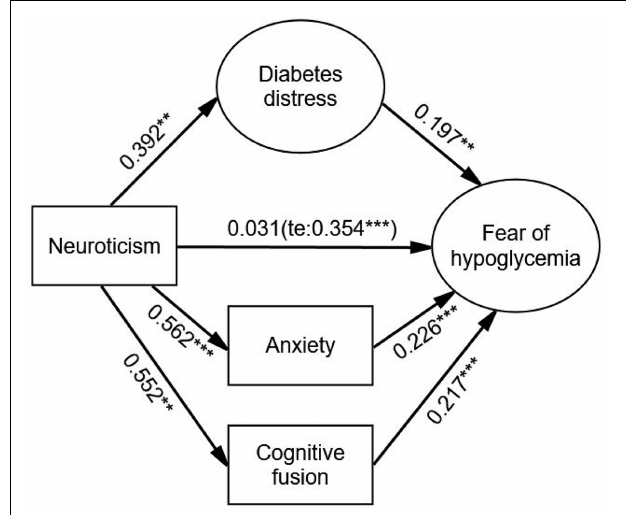
FIGURE 4 | The parallel mediation model with mediator of diabetes distress, anxiety, and cognitive fusion. Standardized estimating of 5,000 bootstrap sample. Age, sex, duration of diabetes, duration of insulin use, hypoglycemic episodes in the past year, and living alone were controlled. te, total effect. Significant codes: *** p < 0.001, ** p <